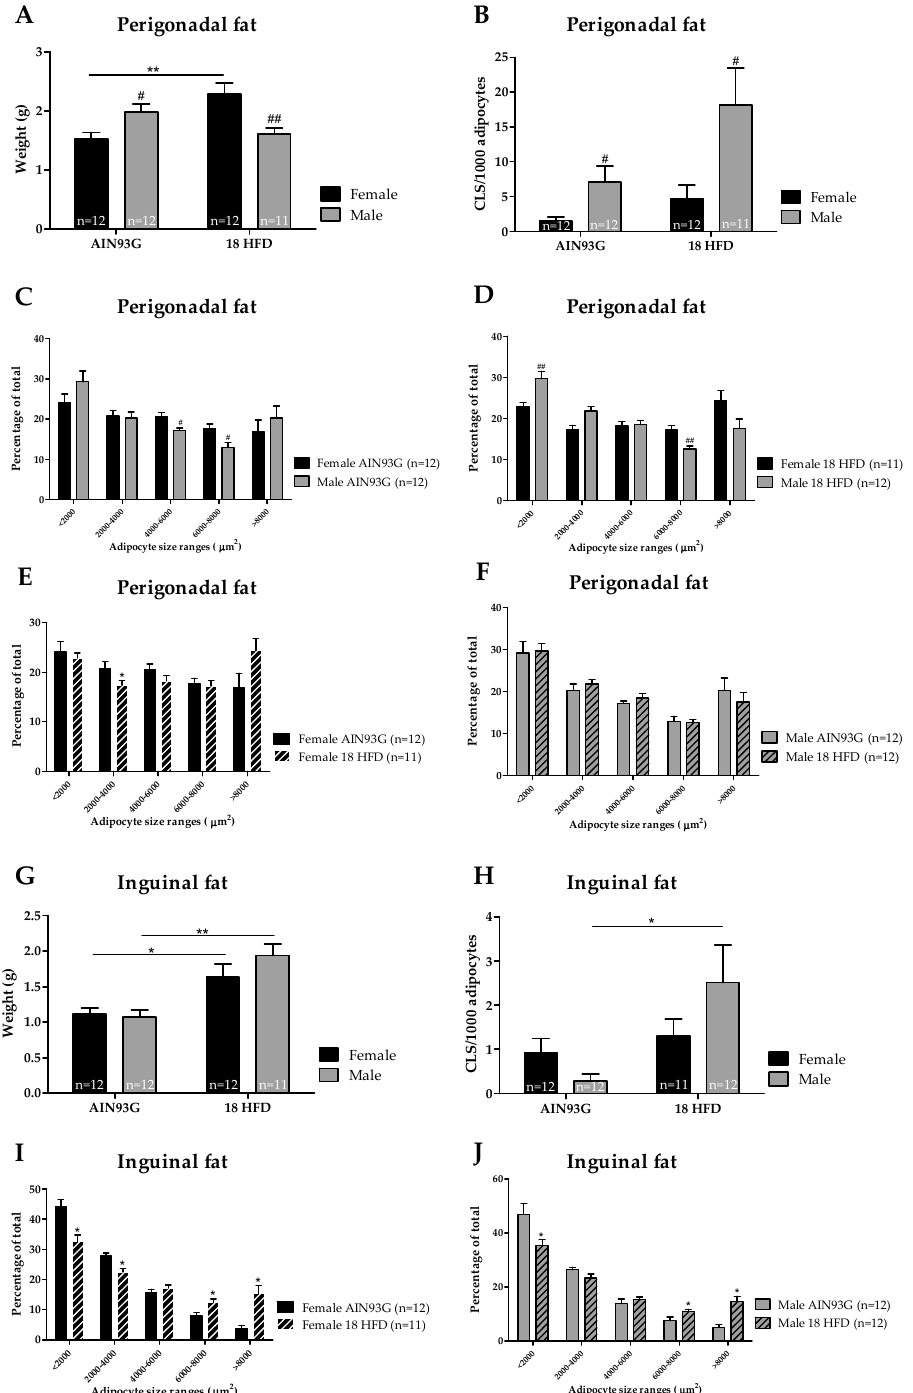
Figure 5. Analysis of perigonadal and inguinal fat depots in Ldlr-/-.Leiden mice after 18 weeks of AIN93G or HFD feeding. Perigonadal fat depot ( A ) weight, and ( B ) adipose tissue inflammation as indicated by crown-like structures (CLS) per 1000 adipocyte. Distribution of adipocyte sizes per diet ( C ) AIN93G, ( D ) HFD, or for ( E ) female mice and ( F ) male mice. The inguinal fat depot in ( G ) weight, and ( H ) adipose tissue inflammation as indicated by crown-like structures (CLS) per 1000 adipocytes. The distribution of adipocyte sizes for ( I ) female mice and ( J ) male mice. * p ≤ 0.050, ** p ≤ 0.010, and *** p ≤ 0.001 significant dietary effect (HFD versus AIN93G). # p ≤ 0.050 and ## p ≤ 0.001 significant sex-specific effect.